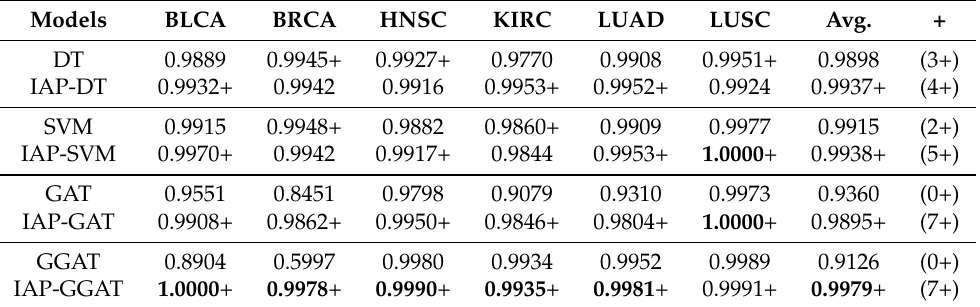
Table 5. F1-score on all